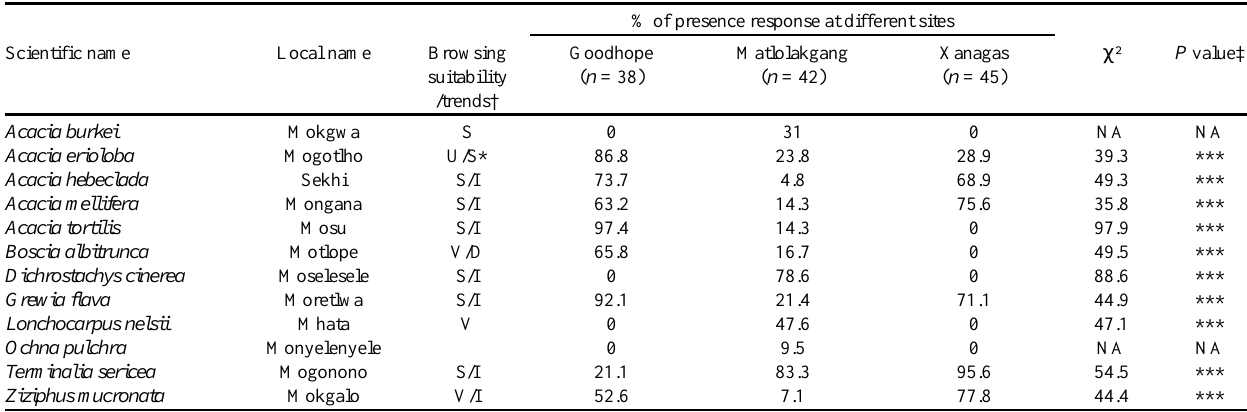
Table 4 . Proportions of farmers who indicated that different woody plant species were dominant within their grazing areas. % of presence response at different